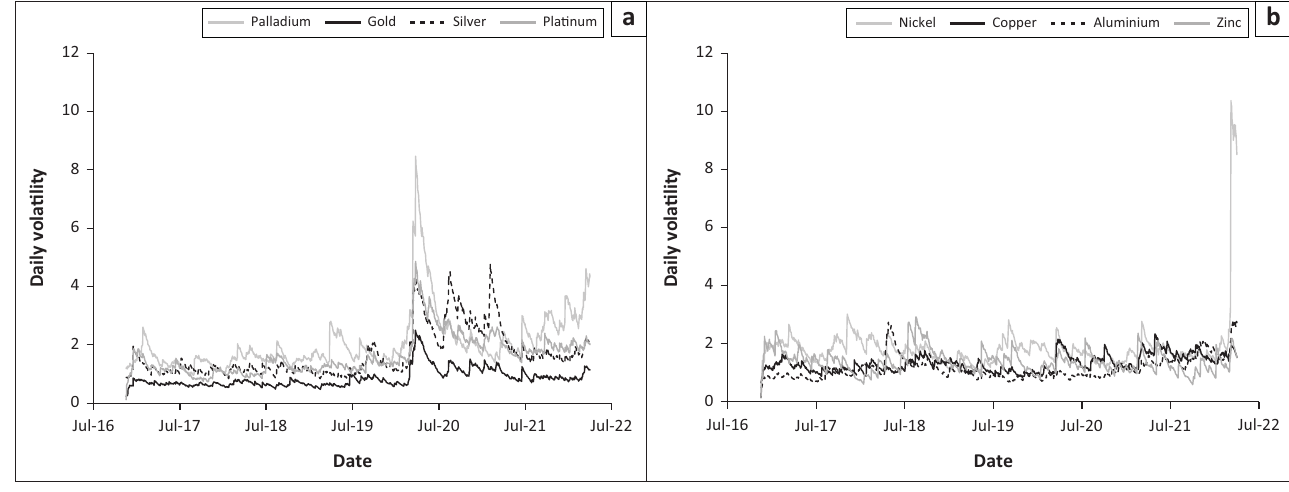
FIGURE 2: Daily volatilities of (a) precious and (b) nonprecious metals (November 2016 – April